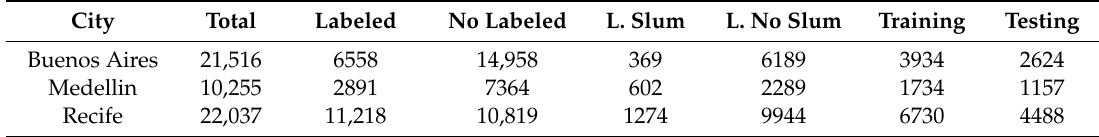
Figure 4. Sampling scheme of slum and no-slum areas for each city. From left to right: Buenos Aires, Medellin, Recife. Table 3. Composition of the dataset (number of fishnet cells).